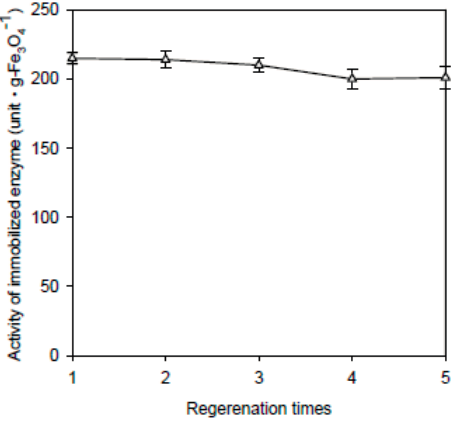
Figure 9. Regeneration of nanoparticles for recoupling. The data are averaged from three samples. ( Δ ) Fe 3 O 4 -CS-immobilized